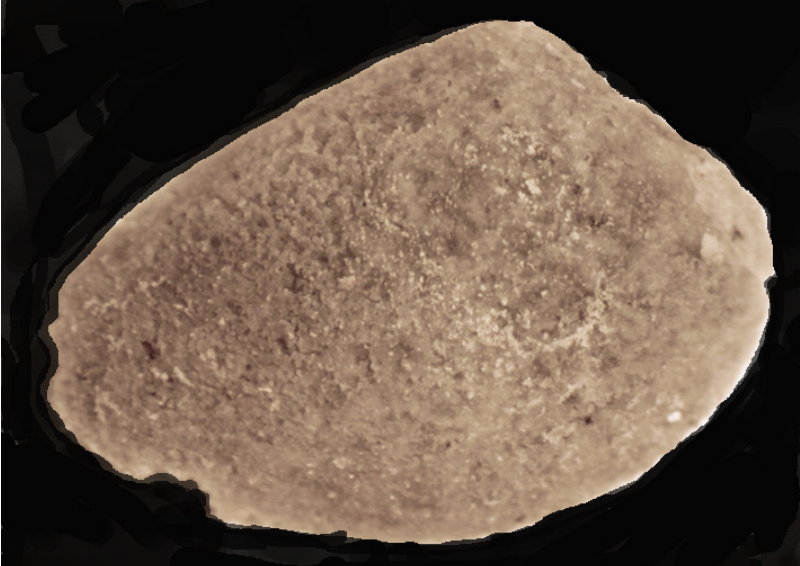
Figure 3. Nuculanoid clam fossil (IGM 5010a). Silicified specimen from acid maceration. Exterior view of subtrigonal left valve. Field sample 12 of 23 May 2014, Late Triassic, Norian Stage ( Tropites welleri - Stikinoceras kerri zones), Shaly Limestone Member of the Luning Formation, Nye County, Nevada. Greatest dimension of shell: 7 mm.